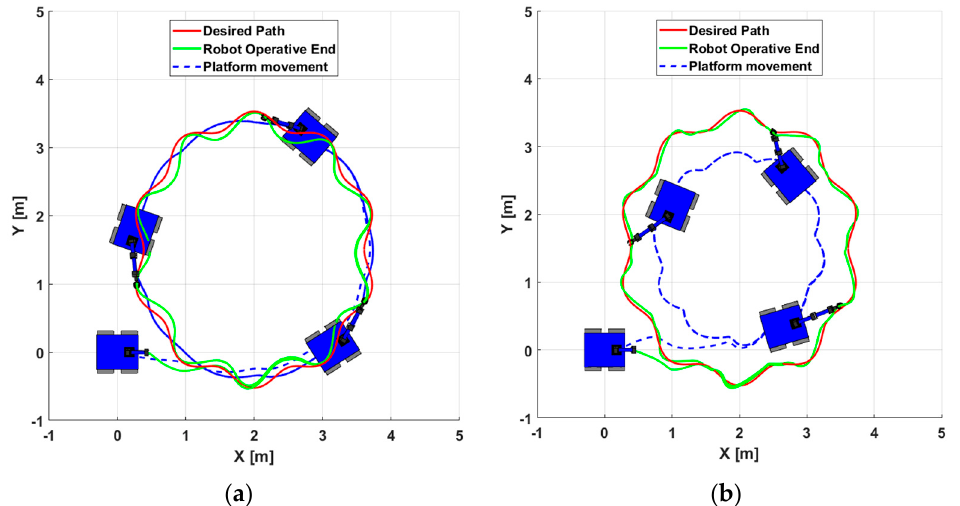
Figure 18. Top view of robotic system travel without consideration of curvature analysis and with consideration of curvature analysis. ( a ) without ROC analysis, ( b ) With ROC analysis.